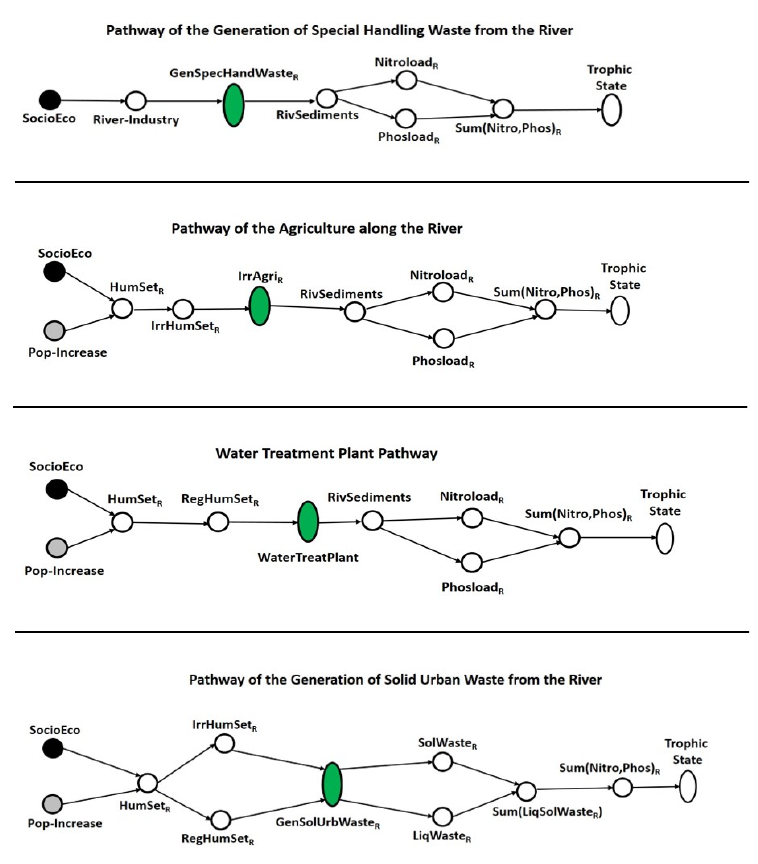
Figure 4. The pathways related to the river.